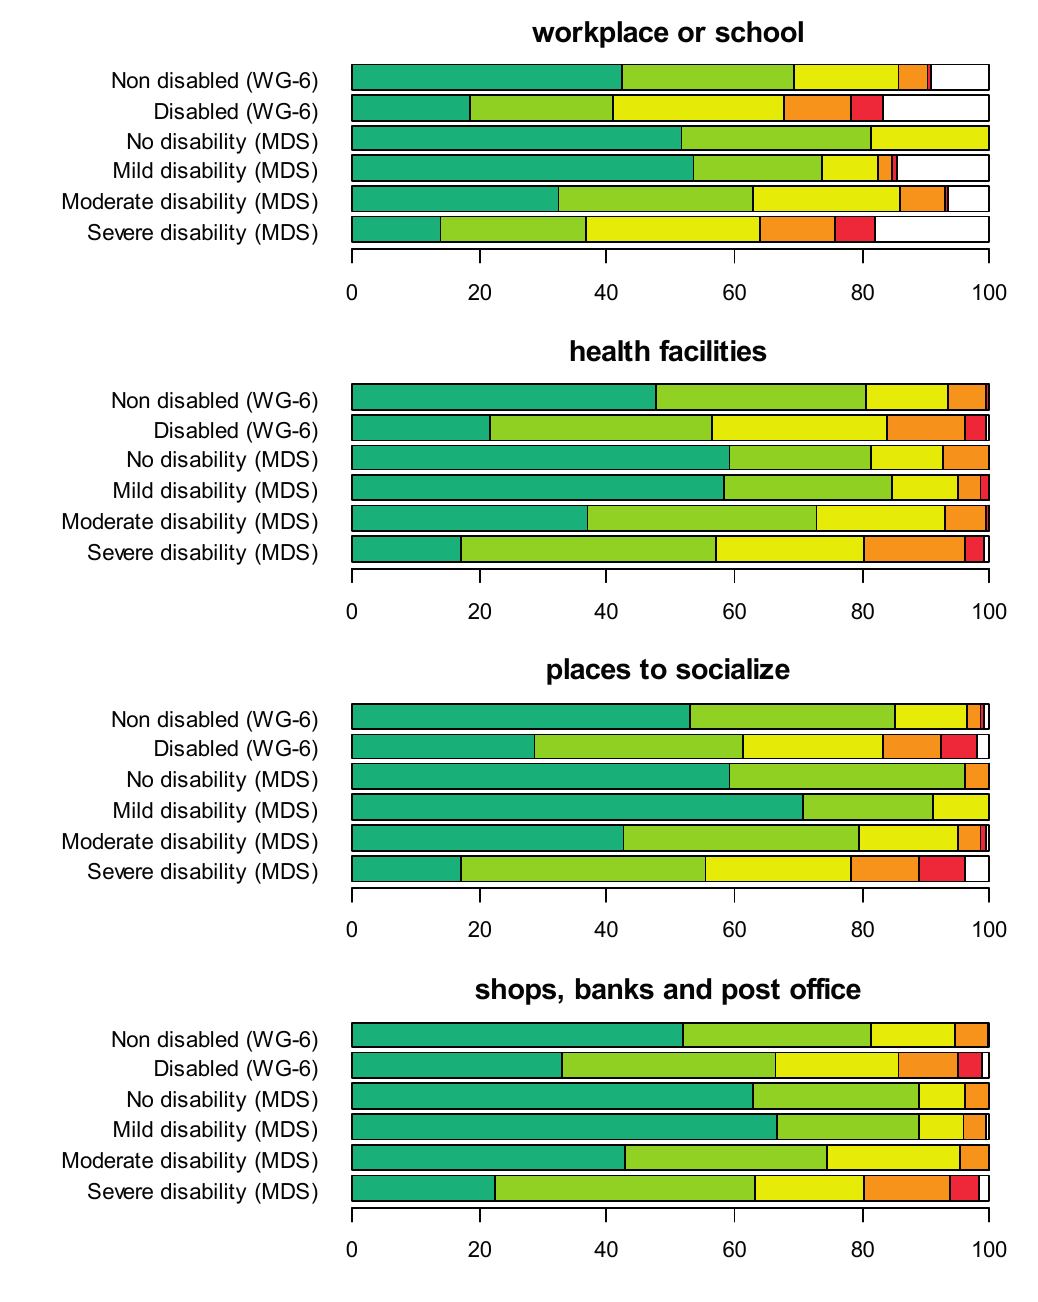
Figure 5. Comparison of the samples generated with the functioning screener approach and the WRD approach for several aspects of the environment that might be hindering and facilitating, on a scale from one to five, where one (dark green) means very easy and five means very hard (red). Dark green: very easy; light green: easy; yellow: neither easy nor hard; orange: hard; red: very hard. MDS, Model Disability